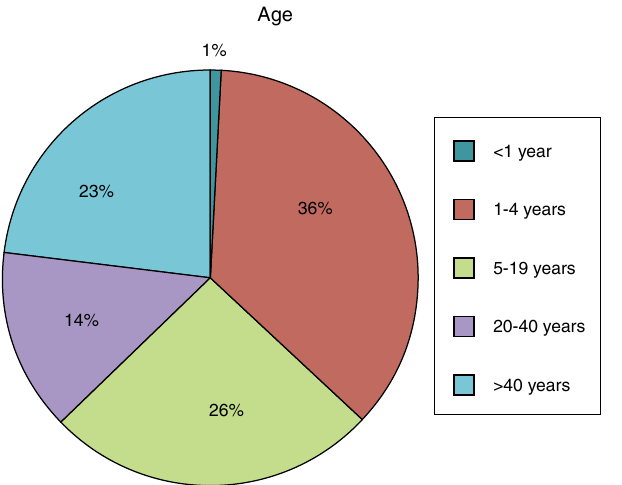
Percentage distribution of patients evaluated in the cochlear implant outpatient clinic according to the language status.